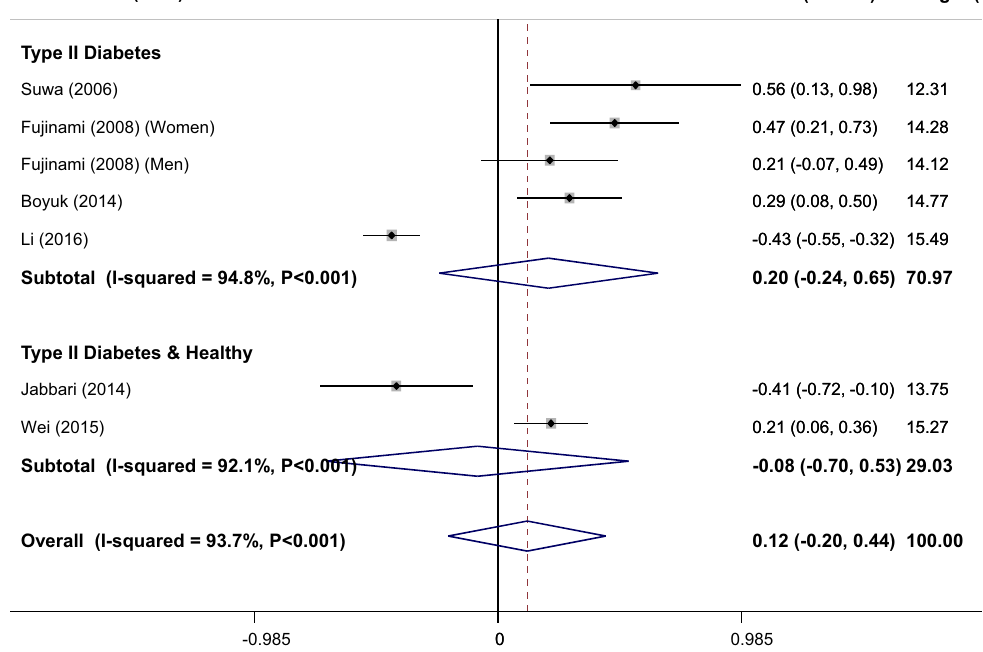
Figure 4. Forest plot of correlation between serum BDNF levels and Homeostatic Model Assessment for Insulin Resistance (HOMA-IR); stratified by health status of participants.